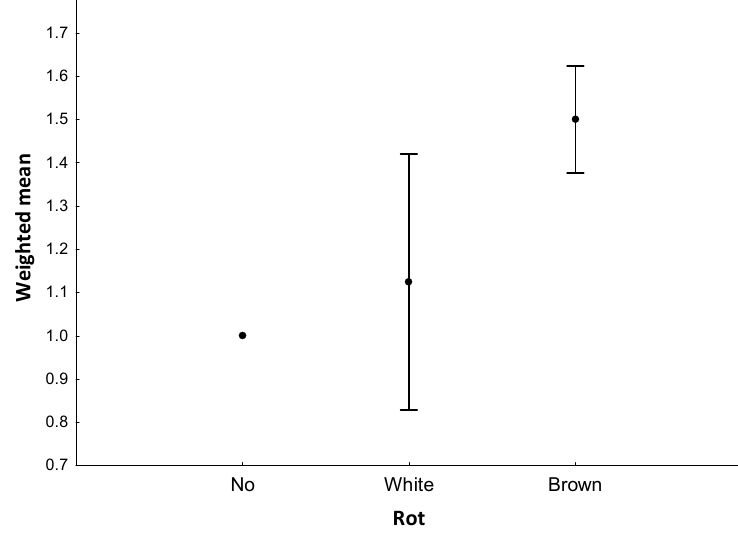
Figure 7. Influence of rot type on incidence of the carpenter ant in the Czech Republic.